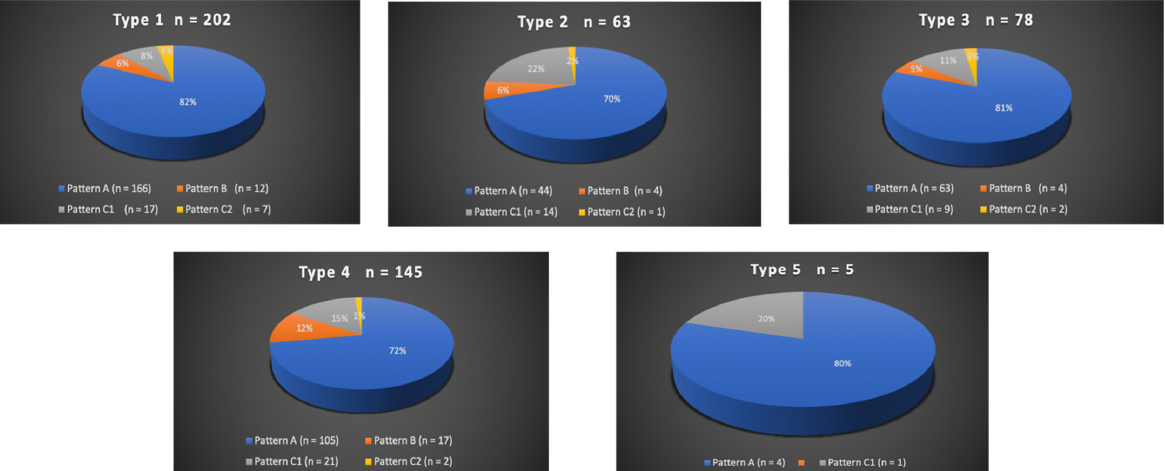
Figure 4. Distribution in study cohort of the patterns of the solitary prostatic arteries according to the different origins. Patterns A, B, and C1 and C2 correspond to the different intra/extra-prostatic supplies of the prostatic artery in the case of a solitary PA (one artery per side, n = 493/622 (79.3%) in this study), according to the Amouyal classification. The values are presented as number, n . Types 1 to 5 represent the possible origins of the PA, according to the Assis classification. The values are presented as a percentage, %. Coil protection was considered as necessary to prevent non-target embolization in 67/311 (21.5%) patients in 78 extra-prostatic supplies. Among pattern B PAs, 30/37 (81%)